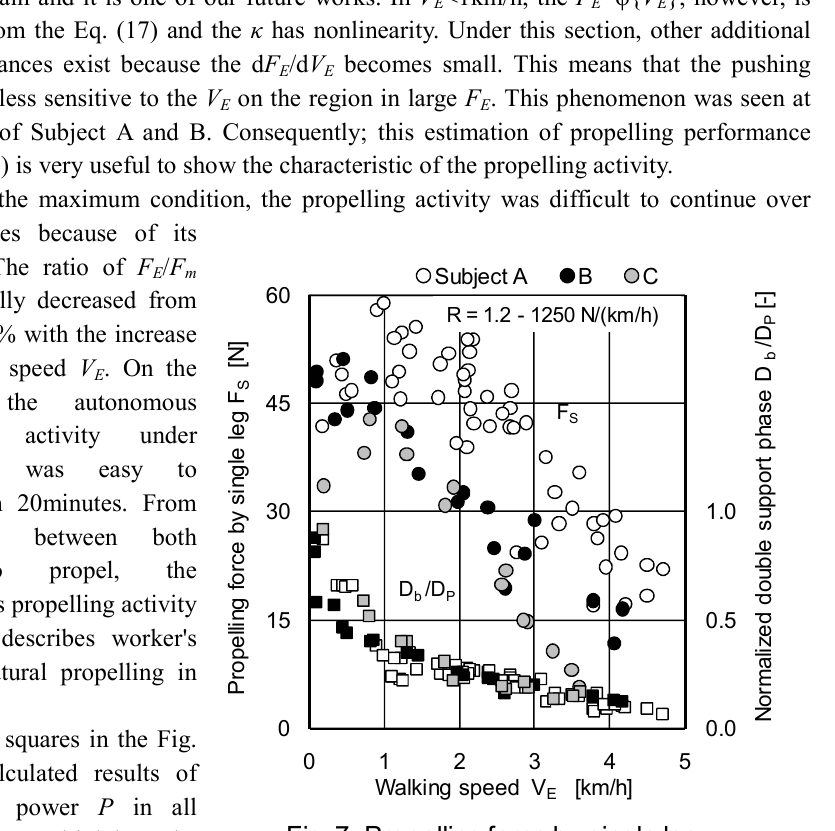
Fig. 7 Propelling force by single